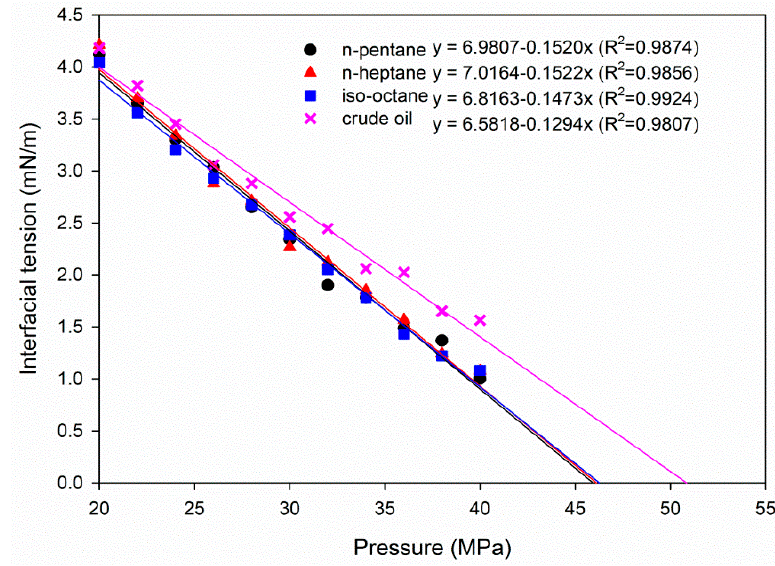
Figure 7. Changes of CO 2 –oil IFTs with pressures for the crude oil diluted with different alkanes.